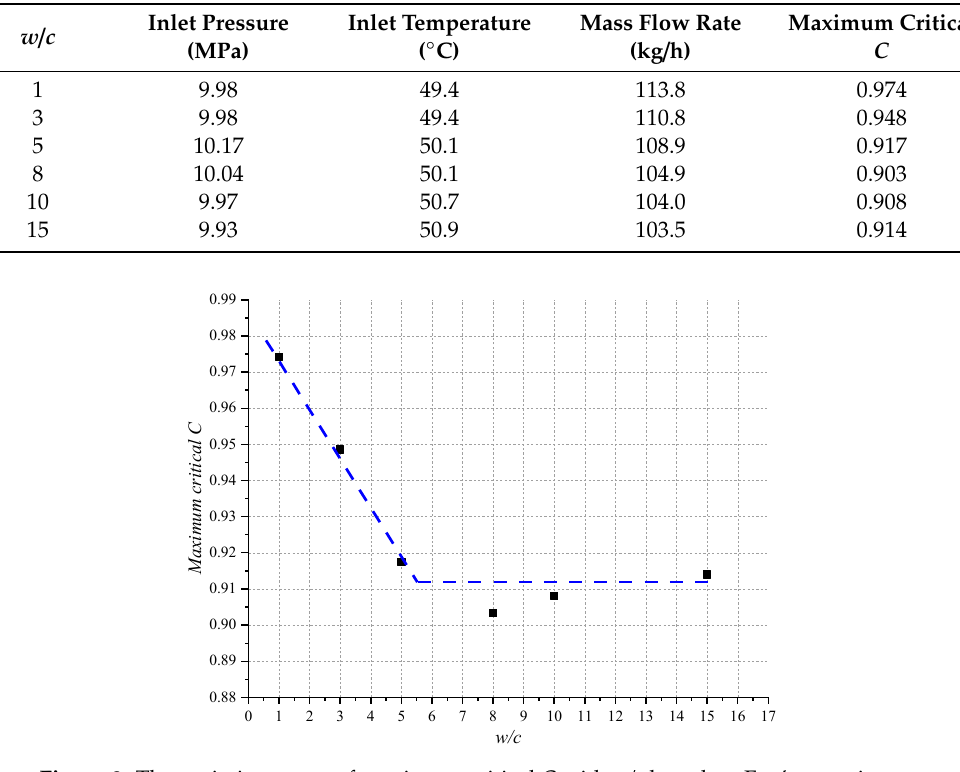
Figure 8. The variation curve of maximum critical C with w / c based on Fan’s experiment.